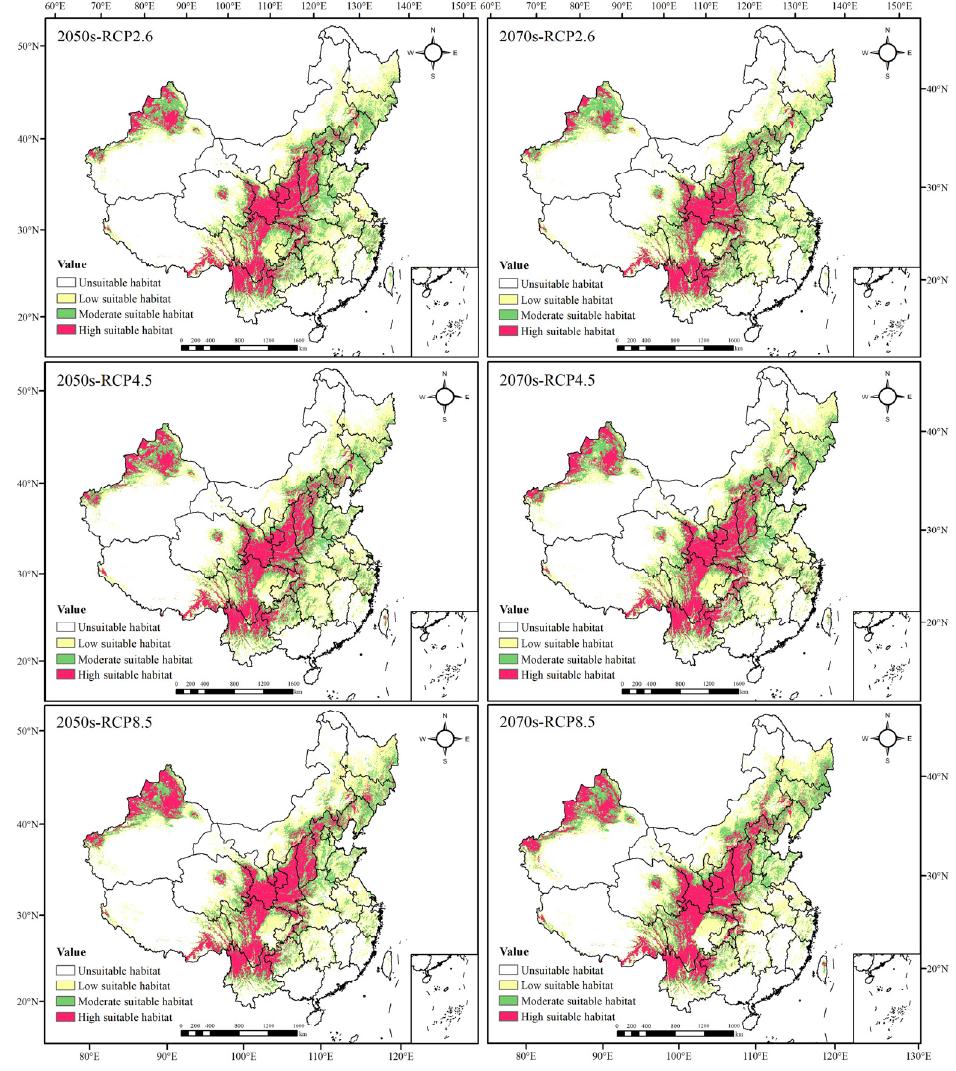
Figure 3. Prediction of potential geographical distributions of Morchella in different climatic scenar- ios.